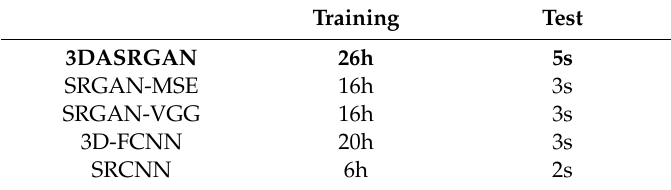
Table 5. The computation time of di ff erent SR methods on the Washington DC Mall